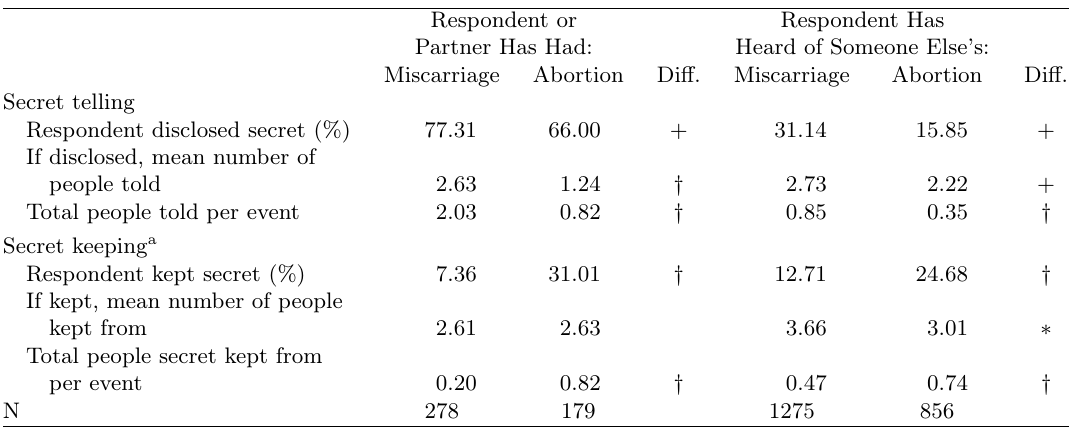
Table 1: Frequency and Magnitude of Secret Telling and Secret Keeping for Own and Others’ Miscar- riages and Abortions, AMACS